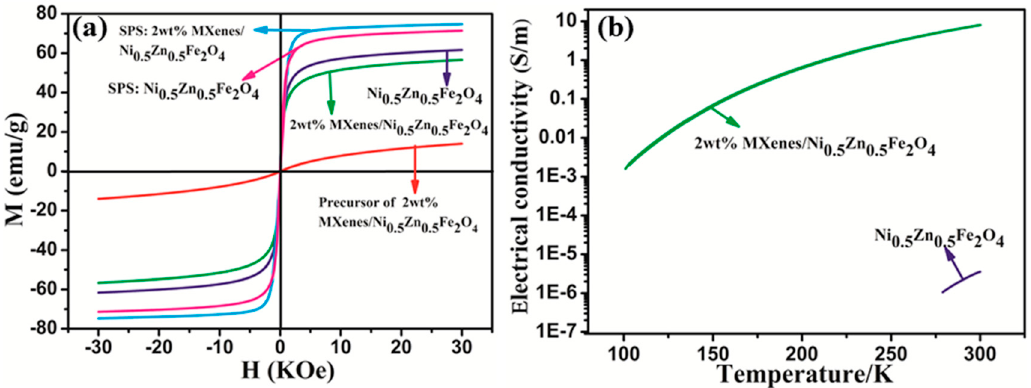
Figure 5. ( a ) Hysteresis loops of precursor, powders, and bulks of pure ferrite and 2 wt.% Ti 3 C 2 T x /NiZn ferrite composites, ( b ) temperature dependence of the electrical conductivity of pure ferrite and 2 wt.% Ti 3 C 2 T x /NiZn ferrite composites.